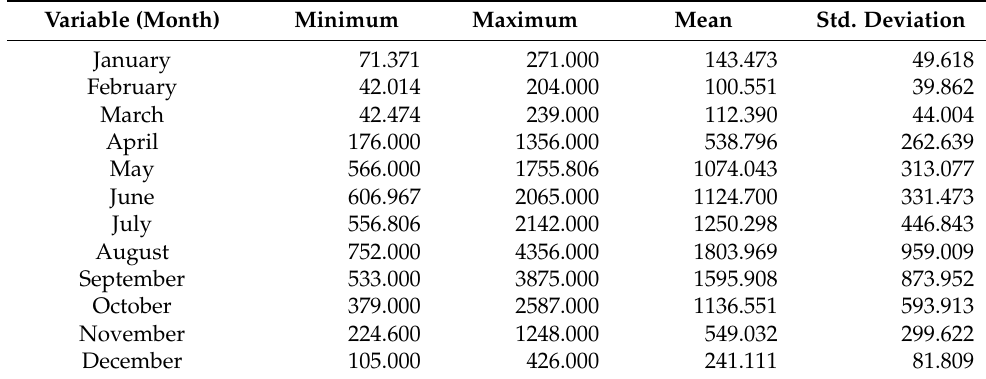
Table 11. Basic statistical characteristics of the Mostovoi runoff data (1990–2017).